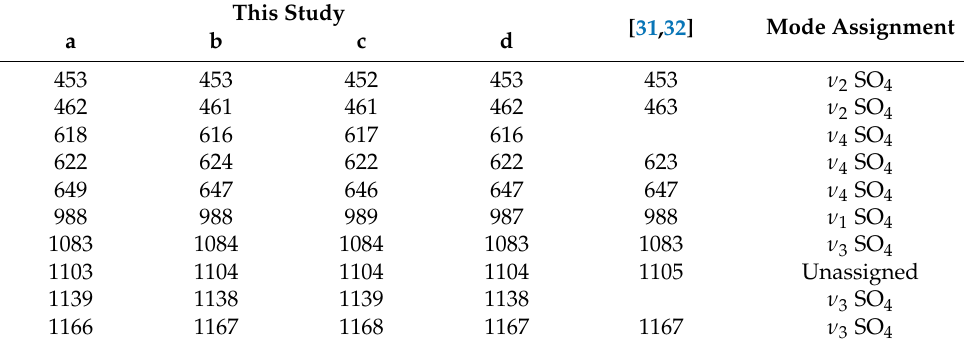
Figure 6. Raman spectra of barite synthesized by mixed solutions at room temperature and in-situ mixes of Na 2 SO 4 and BaCl 2 solutions at 200 ◦ C and a natural sample (RRUFFID = R050375). v 1 , v 2 , v 3 , and v 4 are assigned to the vibrational modes of the SO 4 tetrahedron. ( a ) Synthesized at 200 ◦ C with 0.03 mol/kg Na 2 SO 4 and BaCl 2 solutions, ( b ) Synthesized at 200 ◦ C with 0.1 mol/kg Na 2 SO 4 and BaCl 2 solutions, ( c ) Synthesized at room temperature with 0.03 mol/kg Na 2 SO 4 and BaCl 2 solutions, ( d ) Synthesized at room temperature with 0.1 mol/kg Na 2 SO 4 and BaCl 2 solution. All proportions are molar ratios of Na 2 SO 4 and BaCl 2 solutions. Table 3. Observed Raman vibrational modes (in cm − 1 ) of synthesized barite.